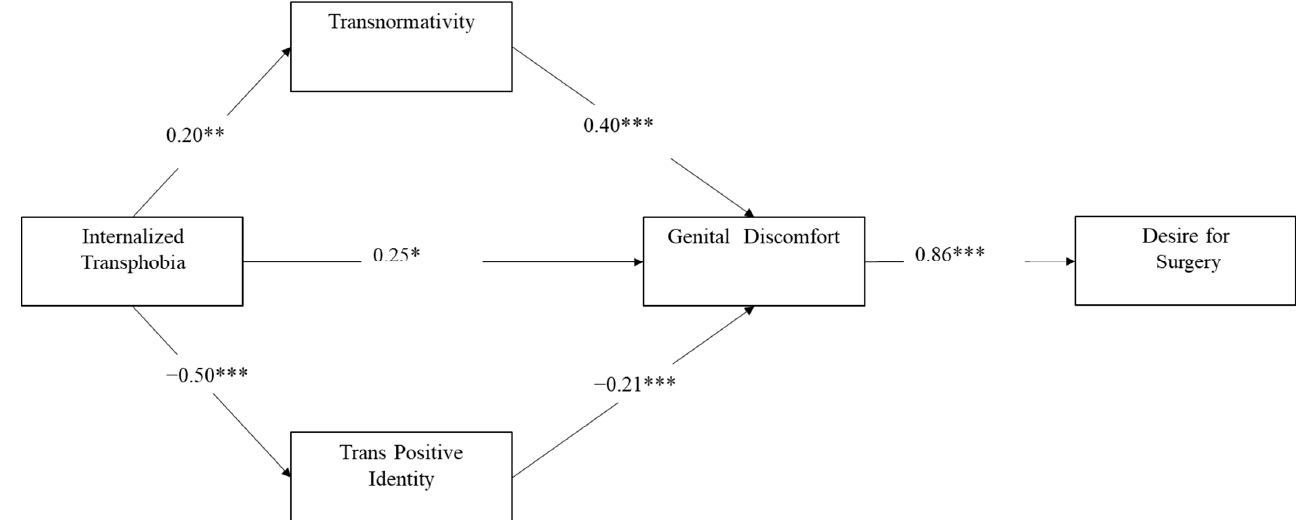
Figure 1. Results from the path analysis. Notes. * p < 0.05; ** p < 0.01; *** p < 0.001.